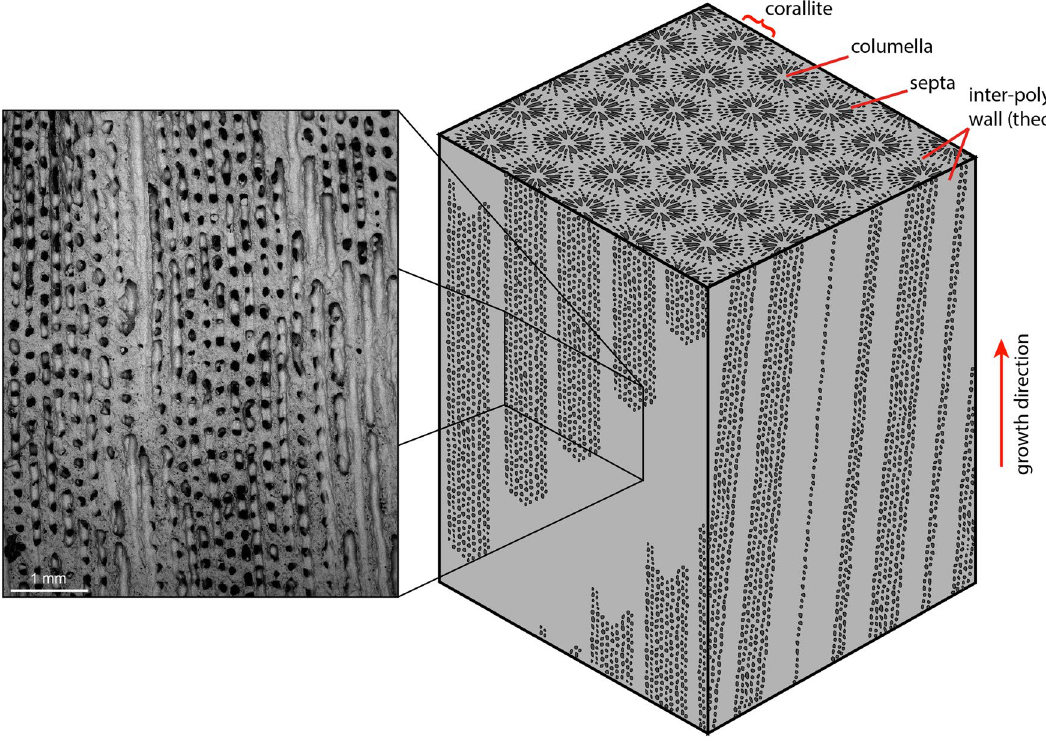
Figure 1. Schematic showing the complex three-dimensional structure of colonial coral skeletal material (in this case Siderastrea siderea ). Coral polyps make up quasi-cylindrical structures (stippled) surrounded by denser wall structures (grey). When sectioned skeletal features will dip into and out of the section plane, as they do not grow along a perfectly straight axis in all dimensions, therefore it is imperative that a detailed understanding